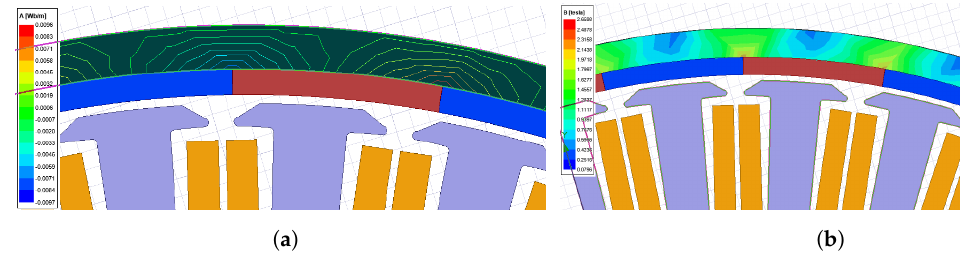
Figure 12. Results from the electromagnetic analyses for a rotor steel sheet thickness of 5 mm: ( a ) magnetic flux lines and ( b ) magnetic flux